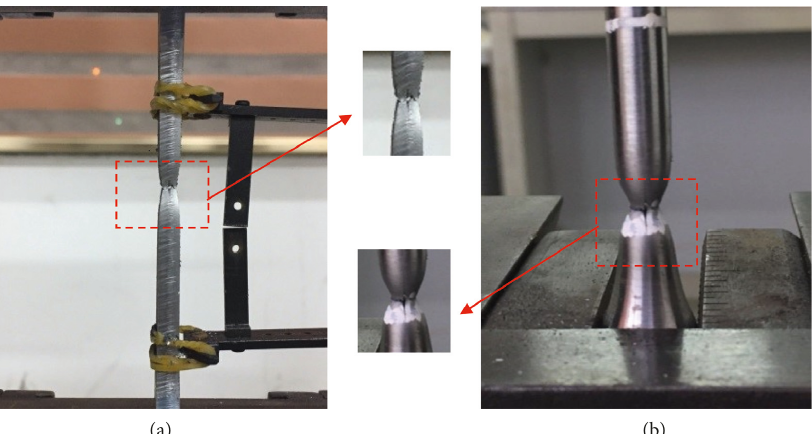
Figure 3: Failure mode I of specimens without welded joint. (a) Sheet material specimen. (b) Rod-shaped specimen.